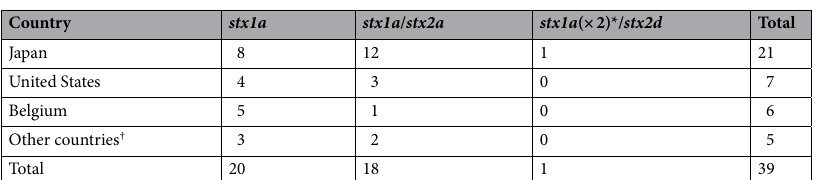
Figure 1. Variation in the integration site of Stx1a phages and Stx1 production between O26:H11 ST21 strains. A maximum likelihood (ML) tree of 39 O26:H11 ST21 strains is shown in the left panel. The tree was constructed based on the recombination-free SNPs (n = 3575) identified on the conserved chromosome backbone (4,340,670 bp) by RAxML using the GTR gamma substitution model. The route was determined by a similar phylogenetic analysis using an ST29C2 strain (090405) as an outlier. The bar indicates the mean number of nucleotide substitutions per site. Genome-closed strains are indicated by filled circles. Along with the tree, the chromosomal locations and types of Stx1a phages in each strain are shown. In the right panel, the levels of LI- and PI-dependent Stx1 production by each strain are shown as the mean values with standard deviations of biological triplicates or quintuplicates. Stx1 productions in all strains grown in the base medium were also measured as controls. Note that the Stx1 production in 12 strains, whose genome sequences were obtained from NCBI, were not determined.